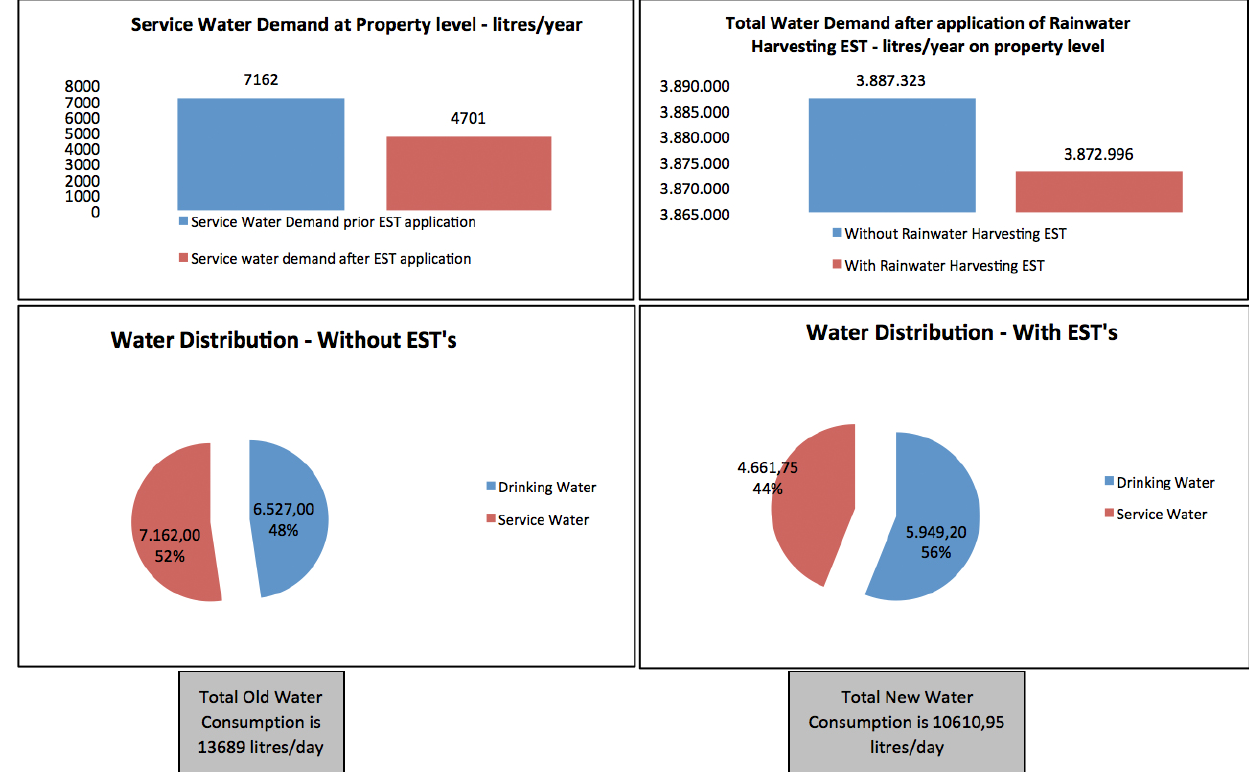
Figure 10. Diagrams on the “Summary” sheet in “Wise Water” illustrating the service water demand at property level, total service water demand after application of rainwater harvesting as well as water distribution with and without ESTs.